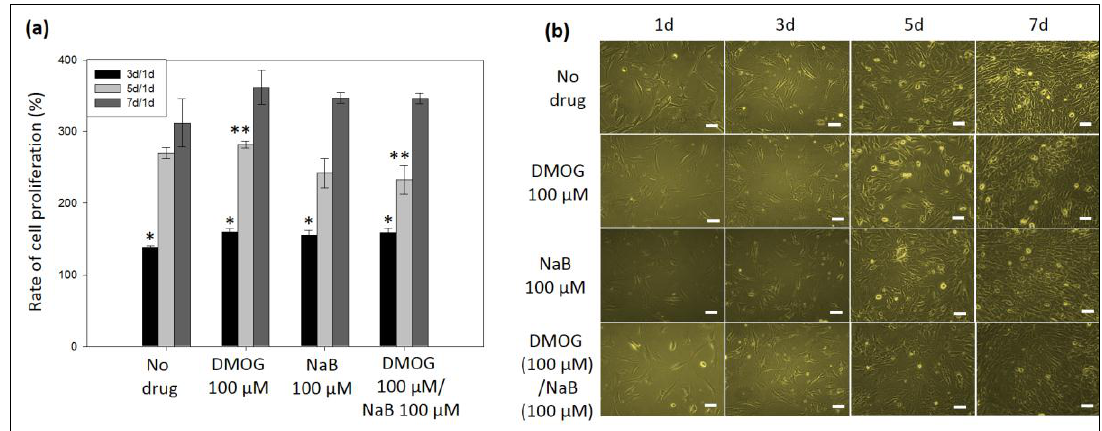
10 of 18 Figure 5. ( a ) Graph of % swelling vs. time for HA-BDDGE patterned gel, and ( b ) in vitro release profile of dimethyloxalylglycine (DMOG) from loaded HA-BDDGE patterned gel over time. From the Figure 5a, it is obvious that the rate of water absorption by the HA-BDDGE polymer was higher at the initial stage, then it decreased and finally attained equilibrium swelling state around at 5 h. The HA-BDDGE patterned gel demonstrated the % of swelling as 439 ± 21%. The swelling property confirmed the formation of hydrogel of crosslinked HA-BDDGE polymer in distilled water at 37 °C. 3.4. In Vitro DMOG Release from Loaded HA-BDDGE Patterned Gel The in vitro DMOG release behavior of DMOG-loaded HA-BDDGE patterned gel with different concentrations of DMOG (25, 50 and 100 µM) is shown in Figure 5b. Release study was performed after the absorption of 25, 50 and 100 µM DMOG. Distilled water (pH 7) was used as medium, while temperature was 37 °C. After 1, 3, 6, 12, 24, 72, 120 and 144 h, absorptions of the aliquots were measured by UV-Vis spectrophotometer (Model: BioMATE 3, Thermo Scientific, Madison, WI, USA). From the release profile (Figure 5b), it is apparent that the initial rate of DMOG release is higher as compared to later stage. This is may be because of the higher rate of swelling of the HA-BDDGE patterned gel and the release of DMOG molecules present on the surface of gel. However, after reaching the equilibrium swelling, the rate of drug diffusion decreased. Among three loaded HA- BDDGE patterned gels (25, 50, and 100 µM), the gel containing 100 µM DMOG exhibited the highest rate of DMOG diffusion (Figure 5b). This is because of the existence of a higher dose of DMOG than that of other grades. In case of 100 µM system, the lesser amount of the % polymer presents in the formulation as compared to 25 and 50 µM systems. Thus, the interaction with HA-BDDGE gel and DMOG will be to certain extent weaker. Besides, the gel layer from which drug molecules diffuse will be weaker and the rate of DMOG release will be faster. After seven days, the % DMOG releases from the HA-BDDGE patterned gel are 93.8 ± 0.6% (for 100 µM), 74.9 ± 0.1% (for 50 µM), and 67.9 ± 0.9% (for 25 µM).